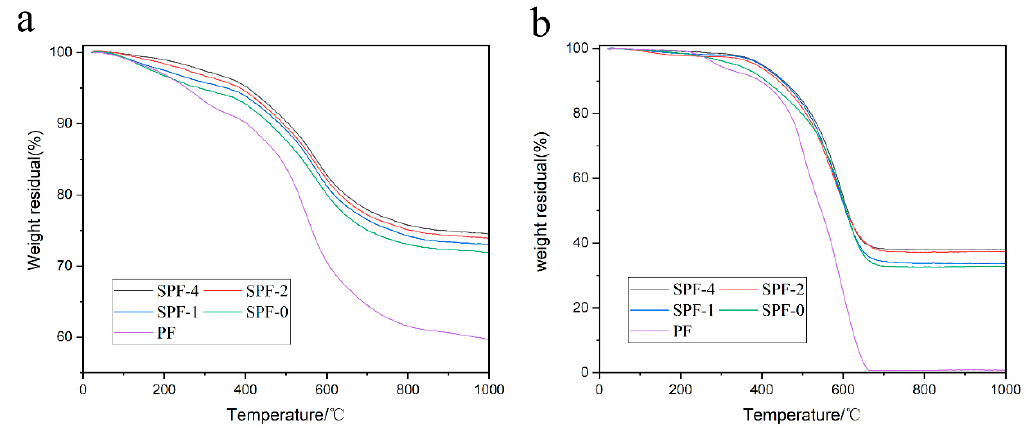
Figure 13. TGA curves of cured PF and SPF resins: ( a ) in N 2 atmosphere and ( b ) in the air atmosphere.